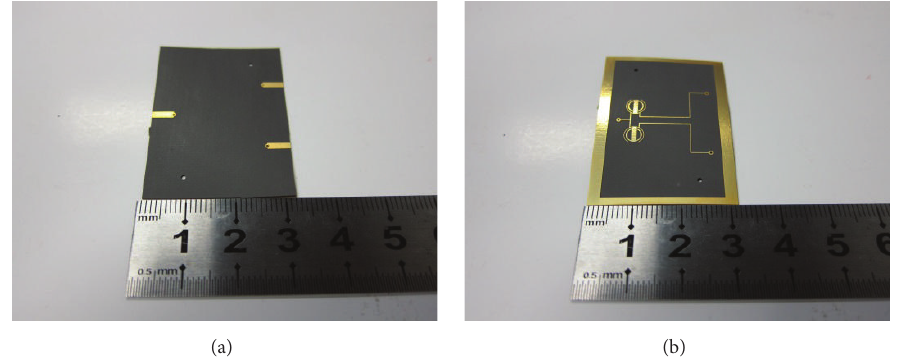
Figure 4: Photograph of the proposed ROGERS5880 substrate. (a) Left view; (b) right view.